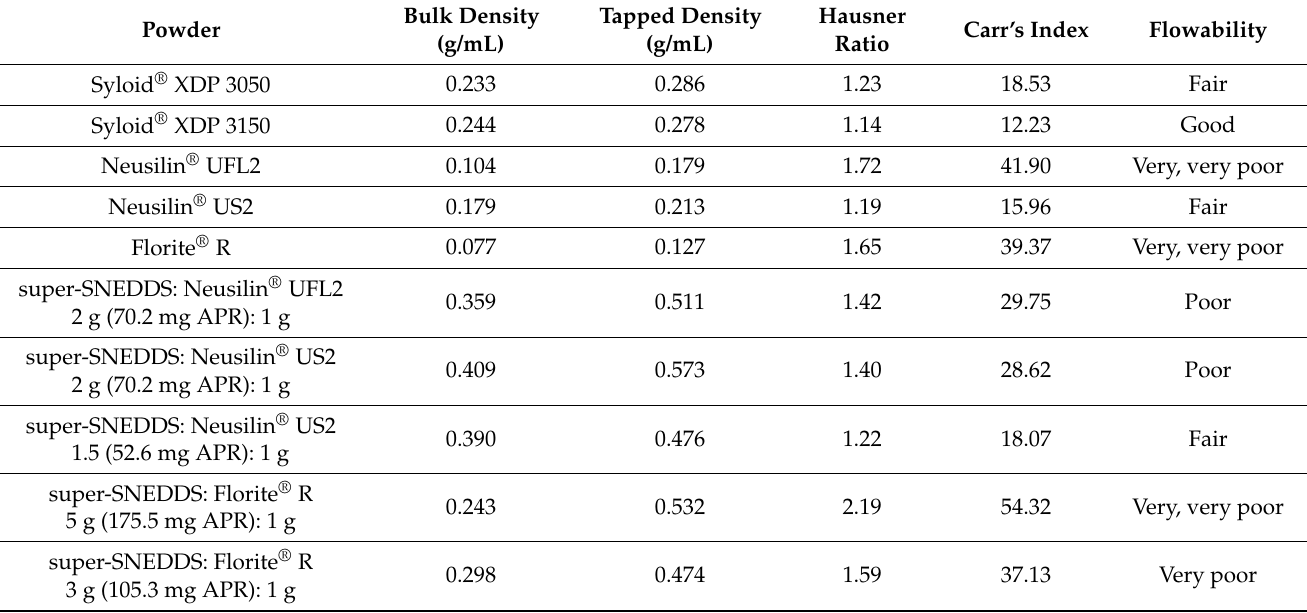
Table 8. Flow properties of adsorbents and various solid